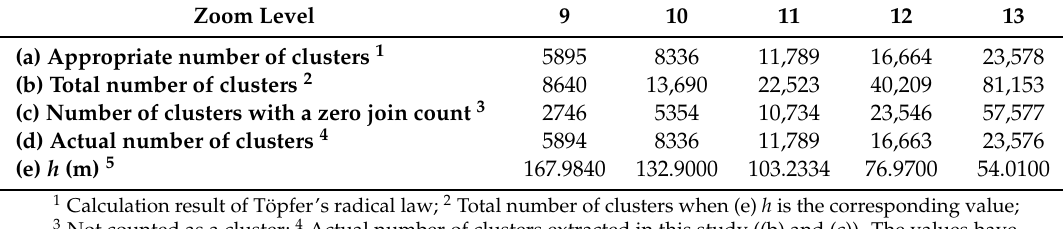
Table 2. Result of appropriate cluster number and size.